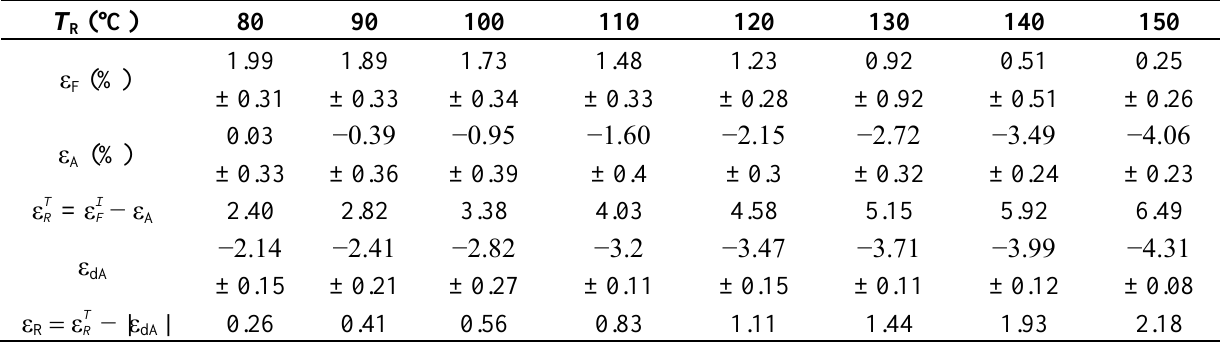
= 7.29 ± 0.9, (ε I = 2.43 ± F F